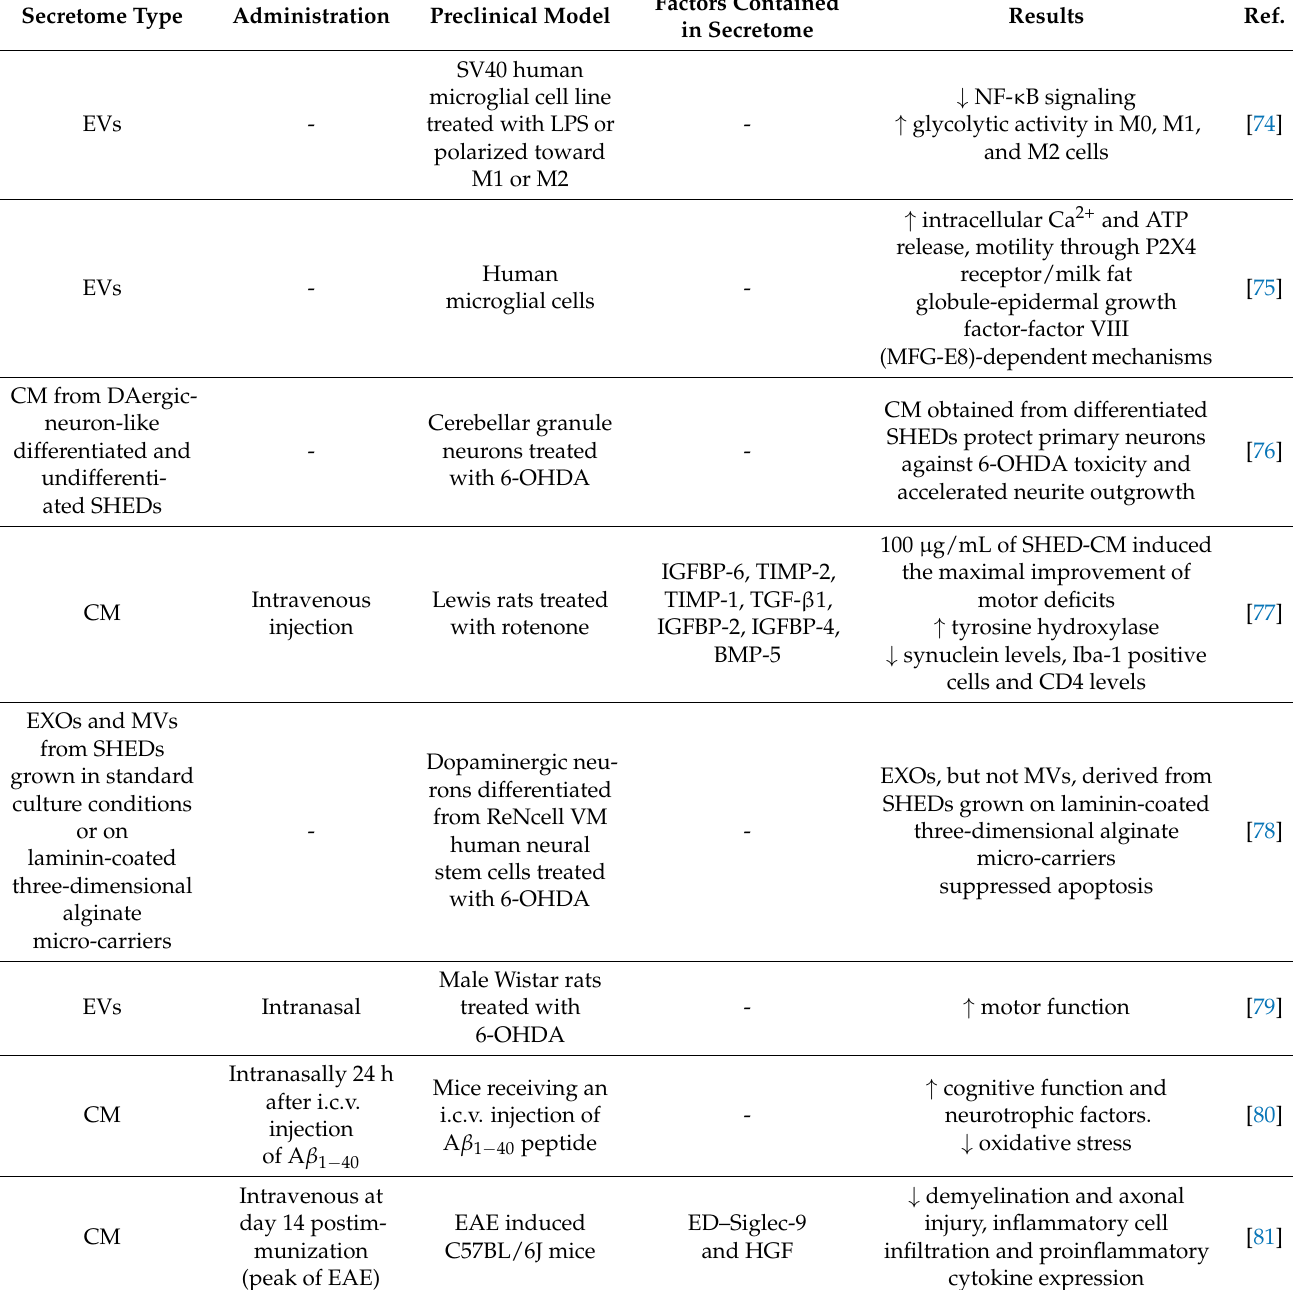
Table 3. Overview of studies involving SHED